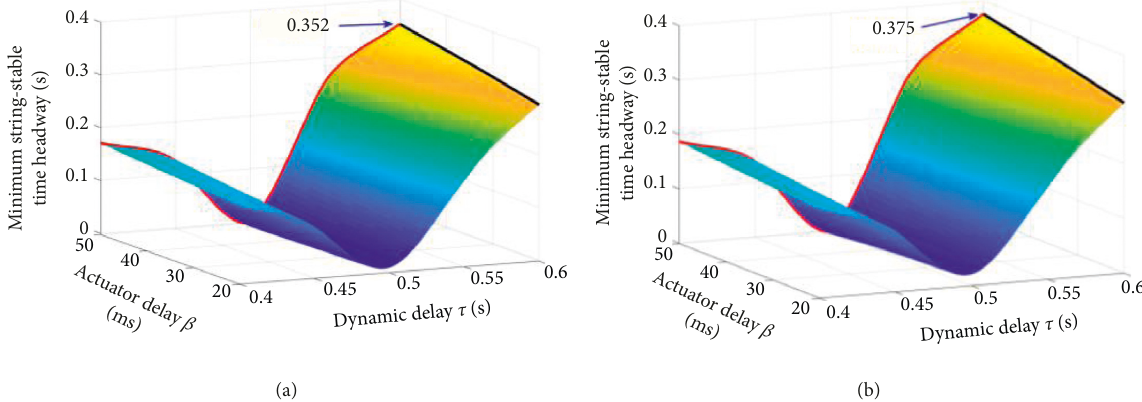
Figure 10: The theoretical minimum string-stable time headway of SPC (a) communication delay is 0ms; (b) communication delay is 100ms.